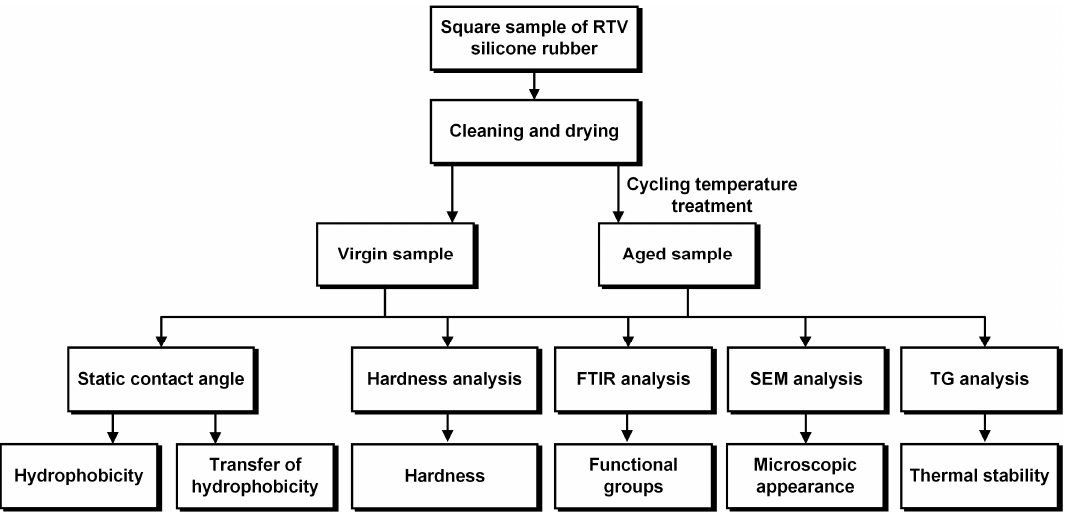
Figure 1. Flowchart of the experiment.